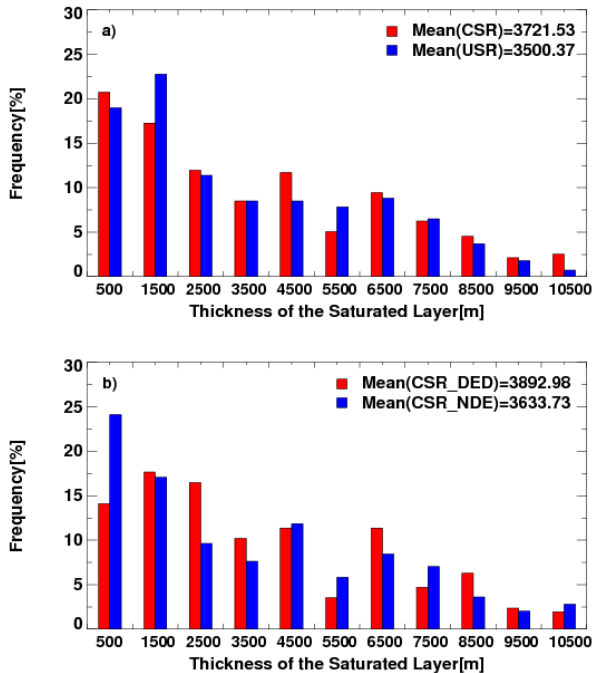
Fig. 10. Same as Fig. 5, but for thickness of cloudy day saturated layer. The histogram intervals are 1000m.